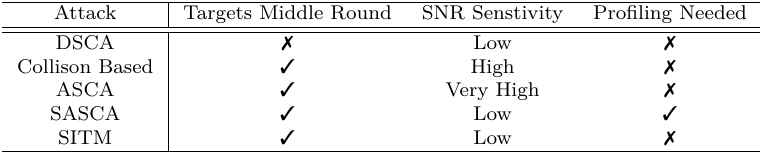
Table 1: Comparison of various side-channel attacks and their applicability to middle